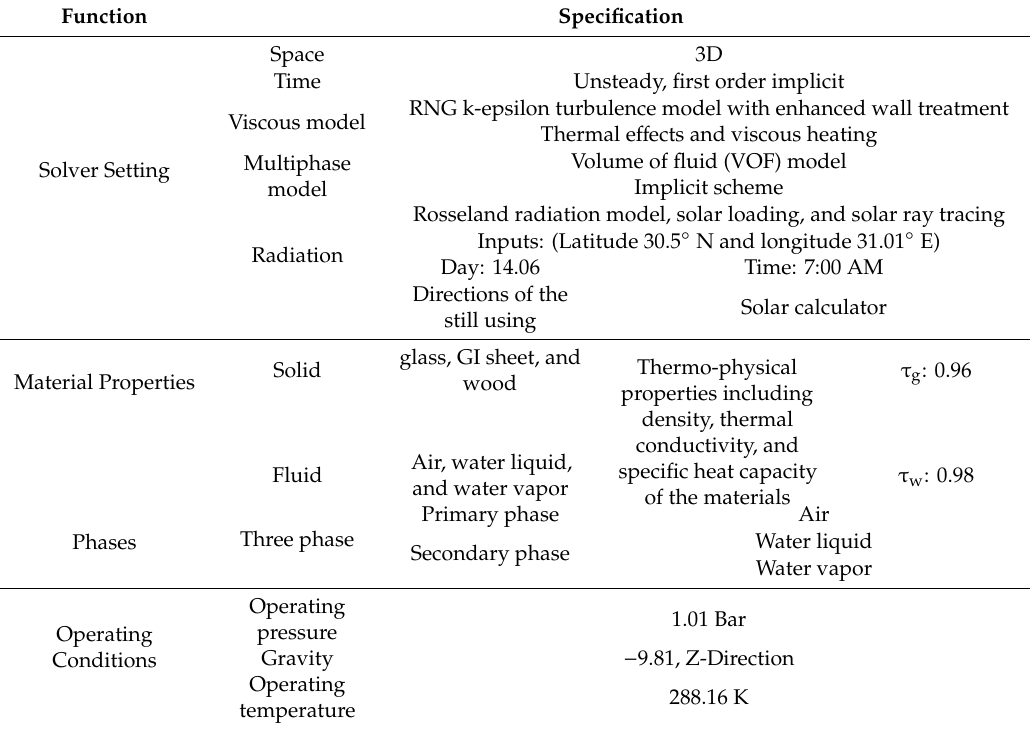
Table 3. Input parameters of